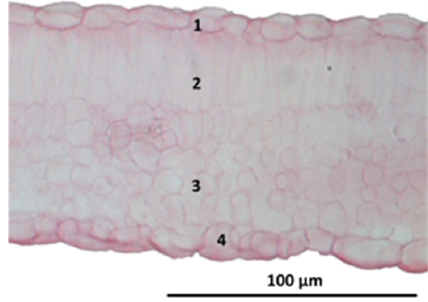
Figure 5. Cross ‐ sections of Vitis vinifera , cultivar Touriga Nacional, leaf mesophyll. 1, Upper epidermal cells; 2, palisade parenchyma; 3, spongy parenchyma; 4, lower epidermal cells.